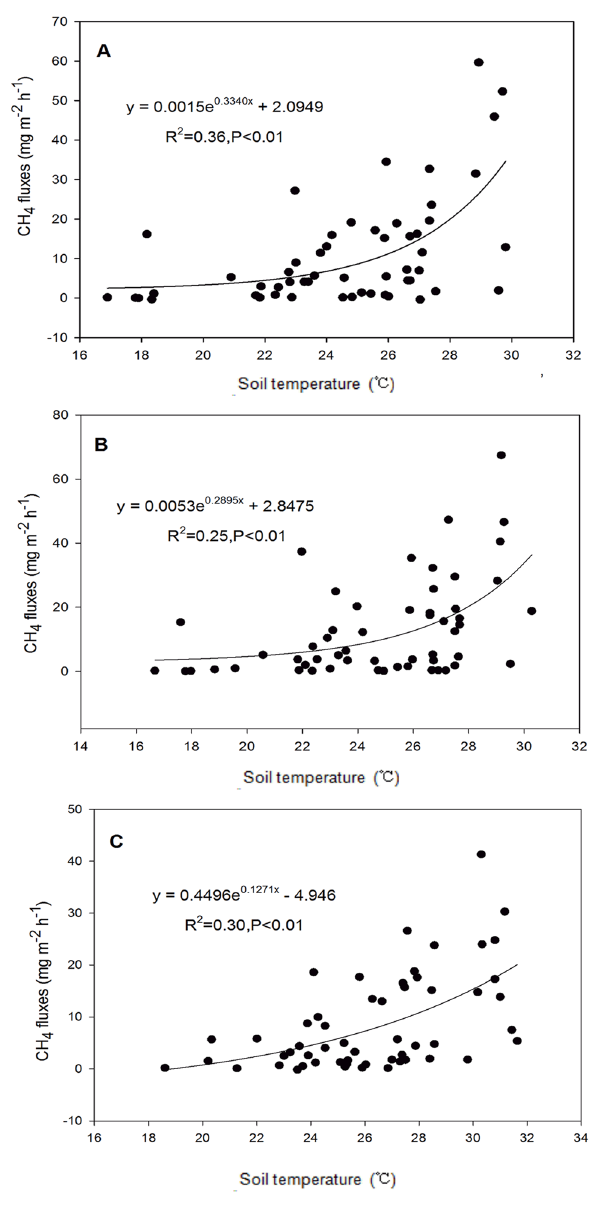
Figure 4. Relationship between soil temperature and CH 4 emission from paddy fields (A for CT at 5 cm depth soil, B for RT at 5 cm depth soil, and C for NT at surface soil ). R 2 : coefficient of